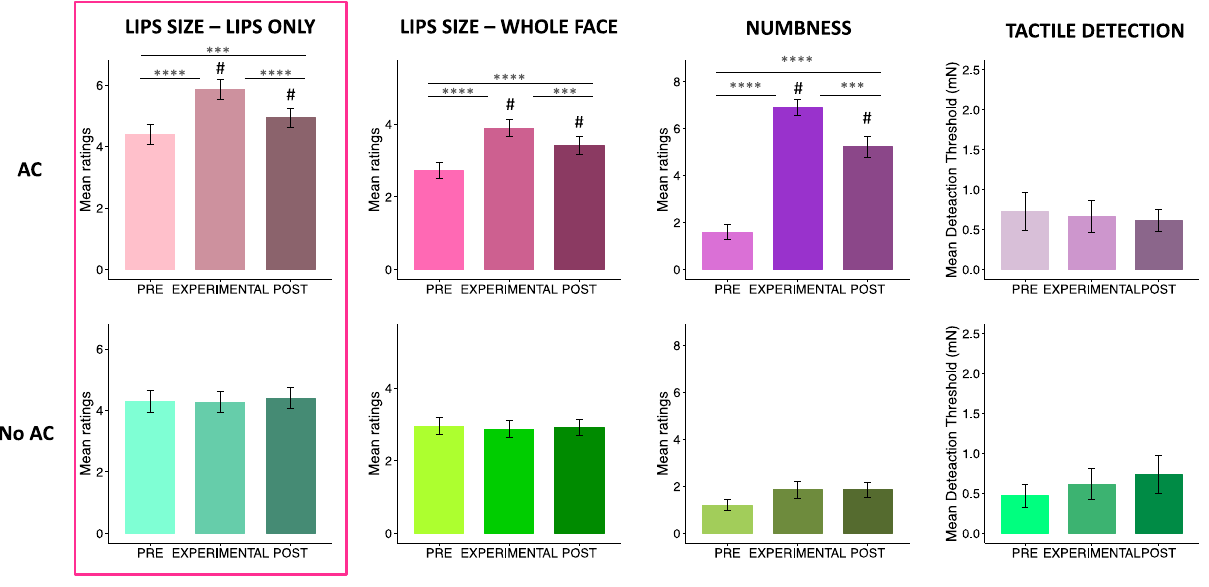
Figure 3. Mean rating scores for the lips size (lips only and whole face ratings), numbness and tactile detection across time points (PRE, EXPERIMENTAL, POST) of Experiment 2. The error bars indicate the standard error of the mean. ** p < 0.01;*** p < 0.005, **** p < 0.001; # p < 0.01 in the difference between conditions (AC and No AC). The pink panel indicates the lip-size measure entered in the LMM analysis in the main manuscript. Results of LMM using the other lip measure are reported in the Supplementary